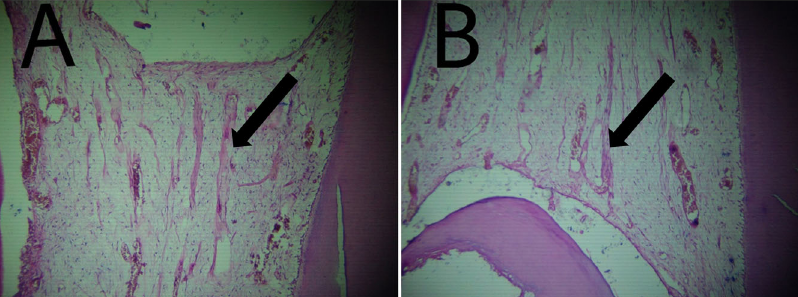
Fig. 3 The arrow points to tissue fi brosis. A Photomicrograph of dental pulp capped with Portland Cement. B Photomicrograph of dental pulp capped with MTA.